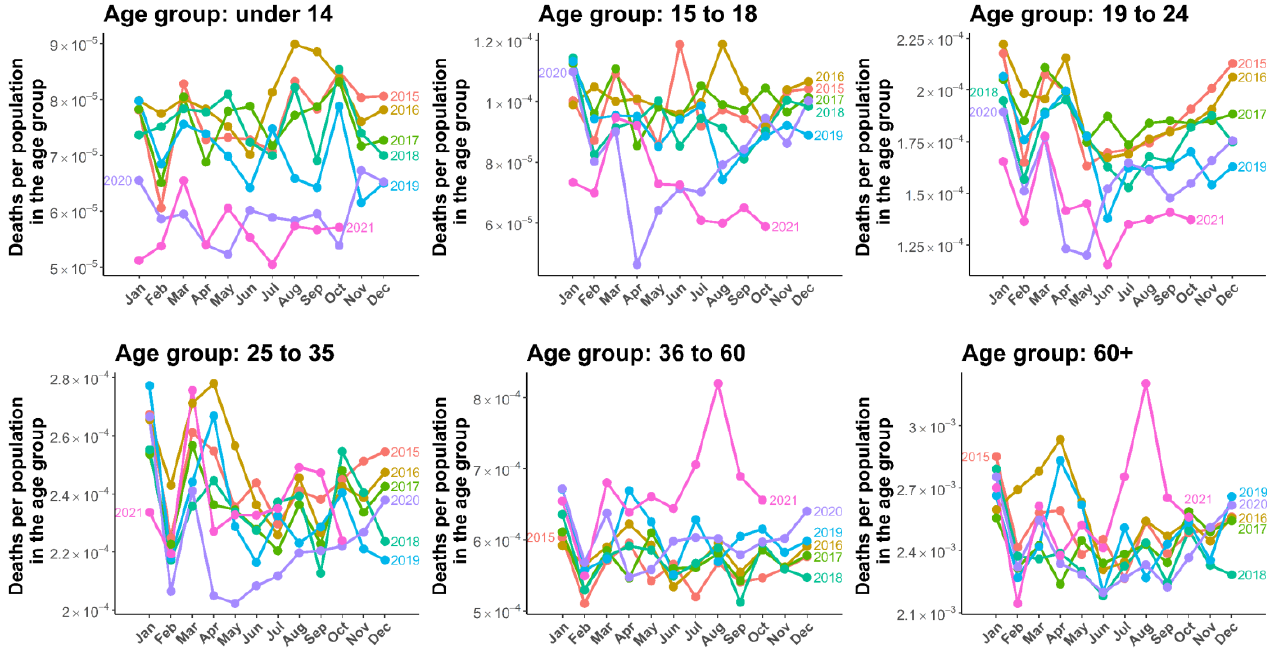
Figure 1. All-cause mortality in men. Lines illustrate the mortality by six age groups (0–14,